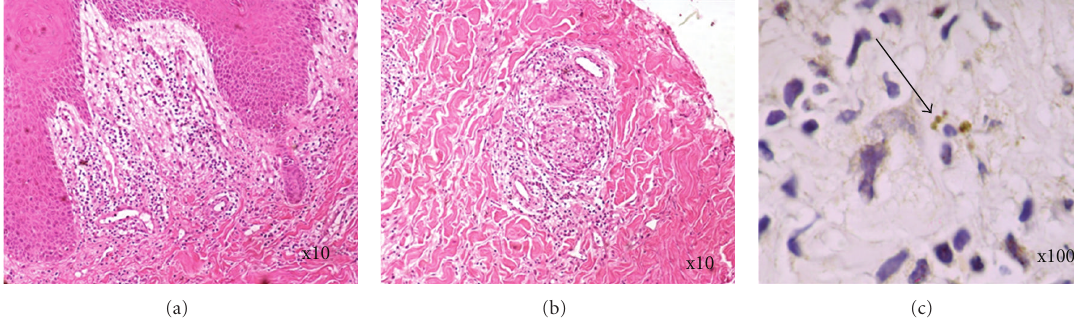
Figure 3: Hematoxylin-eosin staining of biopsy. (a) Edema and chronic inflammation in the papillary dermis (10x). (b) Granuloma in the dermis (10x). (c) Immunohistochemistry staining of L. braziliensis amastigotes ((100x) arrow).